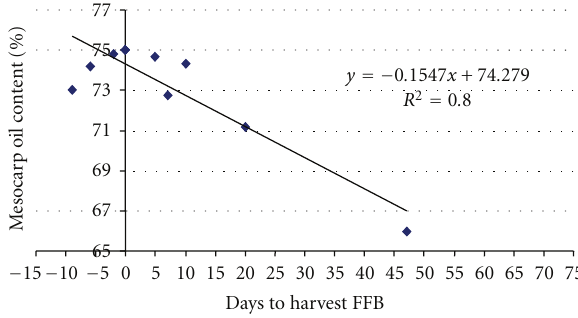
Figure 11: Estimation model of mesocarp oil content for harvesting date prediction.